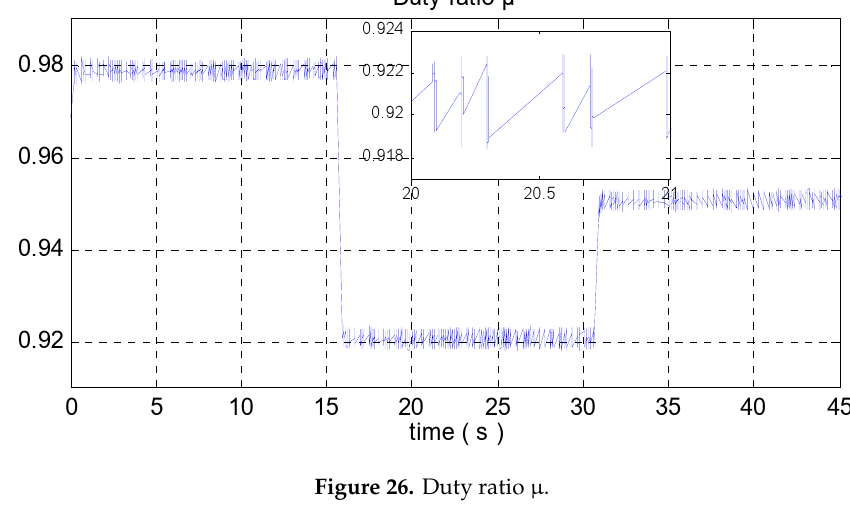
Figure 25. Fuel cell voltage V fc .